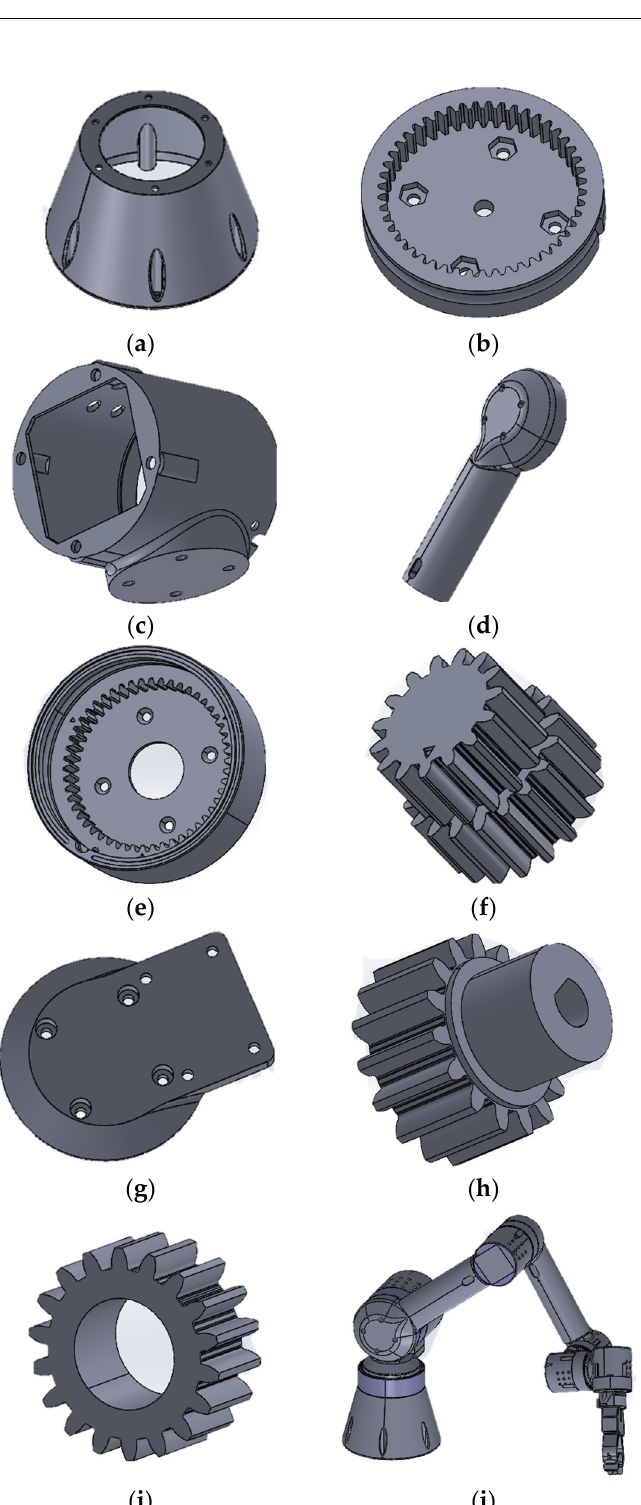
Figure 5. ( a ) Conical base of the manipulator; ( b ) toothed ring; ( c ) shoulder; ( d ) extension arm; ( e ) toothed ring with motor mount; ( f ) secondary double pinion; ( g ) shoulder pad; ( h ) main single pinion; ( i ) toothed wheel; ( j ) robotic arm.